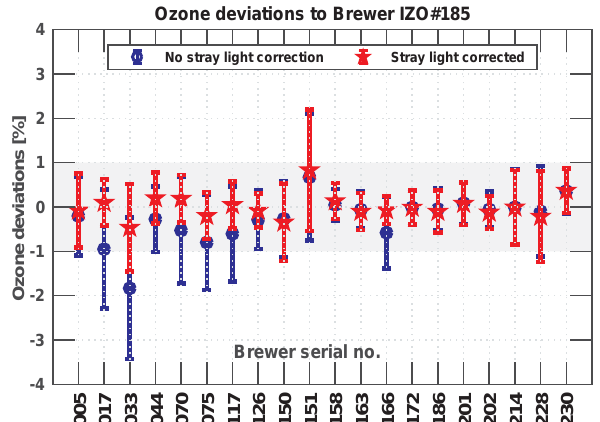
Figure 13. Final days mean percentage difference with respect to the reference Brewer for the simultaneous direct sun measurements for all the participating instruments. Blue circles shows results with- out the stray light correction and red stars show results with the cor- rection applied to single Brewer